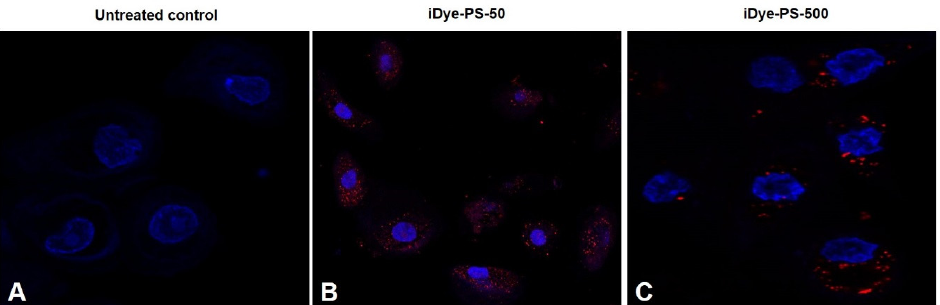
Figure 3. The confocal images depict the internalization of iDyePS-50 and iDyePS-500 in HNEpCs after exposures (100 μ g/mL) lasting for 24 h. ( A ) Untreated control. ( B ) Localization of iDyePS-50 (in red) in cytoplasmic regions and surrounding nuclei (blue). ( C ) Presence of iDyePS-500 (in red) in the cytoplasm and proximity to